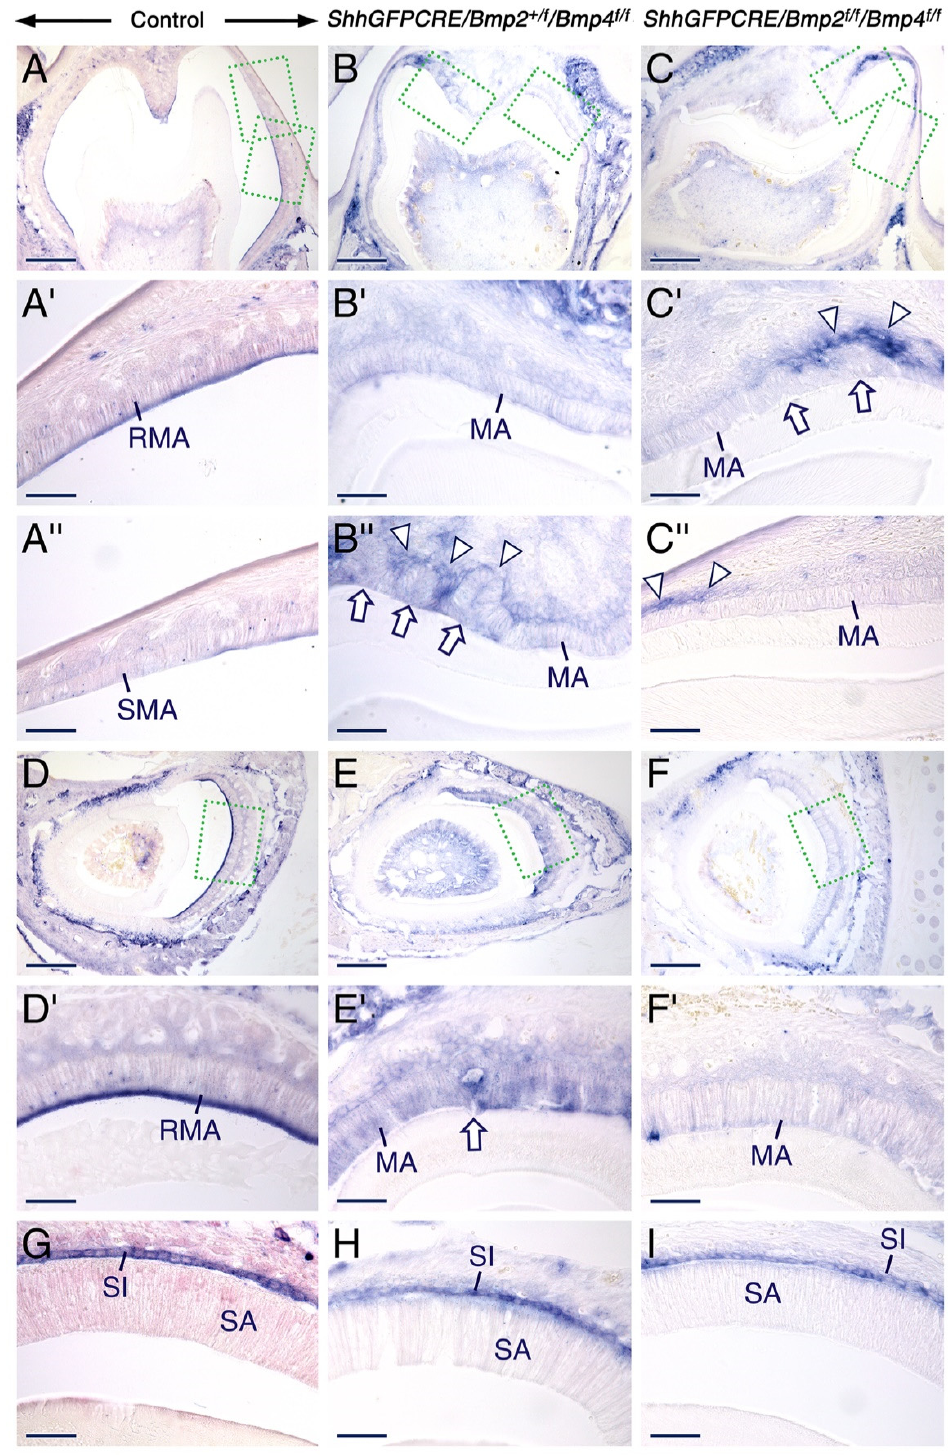
Figure 4. Combined loss of BMP2 and BMP4 signaling in the dental epithelium affects alkaline phos- phatase activity at the maturation stage of amelogenesis. ( A – I ) Representative alkaline phosphatase histochemistry data in cryostat sections across molars ( A – C ) and incisors ( D – I ) from 12 days post- partum control ( A , D , G ), ShhGFPCRE/Bmp2 +/f /Bmp4 f/f ( B , E , H ), and ShhGFPCRE/Bmp2 f/f /Bmp4 f/f ( C , F , I ) mice showing the distribution of alkaline phosphatase activity (dark blue). ( A’ – C’ ) and ( A’’ – C’’ ) are magnified views of the boxed areas in ( A – C ). ( D’ – F’ ) are magnified images of the boxed areas in ( D – F ). In control teeth, alkaline phosphatase activity is strong in the apical border of ruffle-ended maturation-stage ameloblasts (RMA; ( A’ , D’ )) as well as in intracytoplasmic vesicles in RMA ( A’ , D’ )